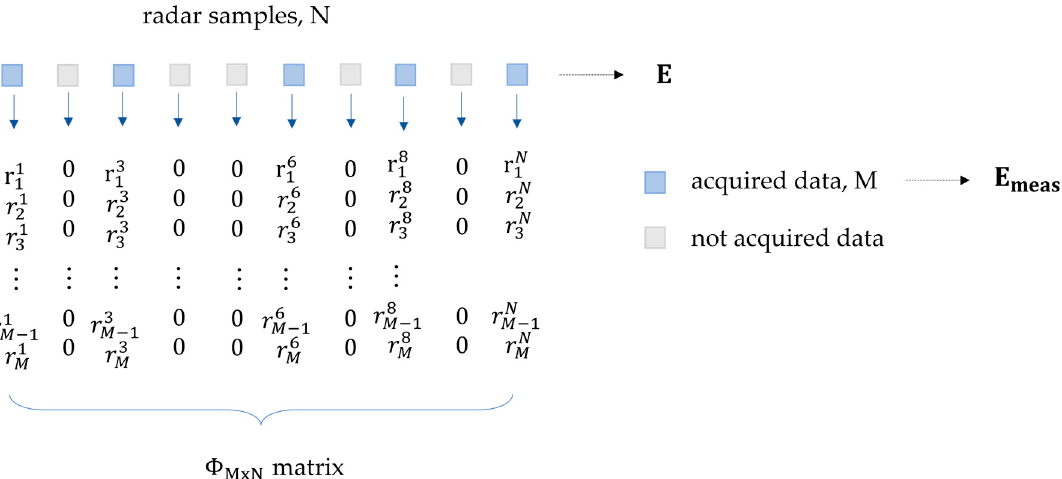
Figure 1. Theoretical scheme for the definition of the φ matrix. Here, the coefficients r j are random numbers between zero and one, for all i = 1, . . . ,M and j = 1, . . . , N .